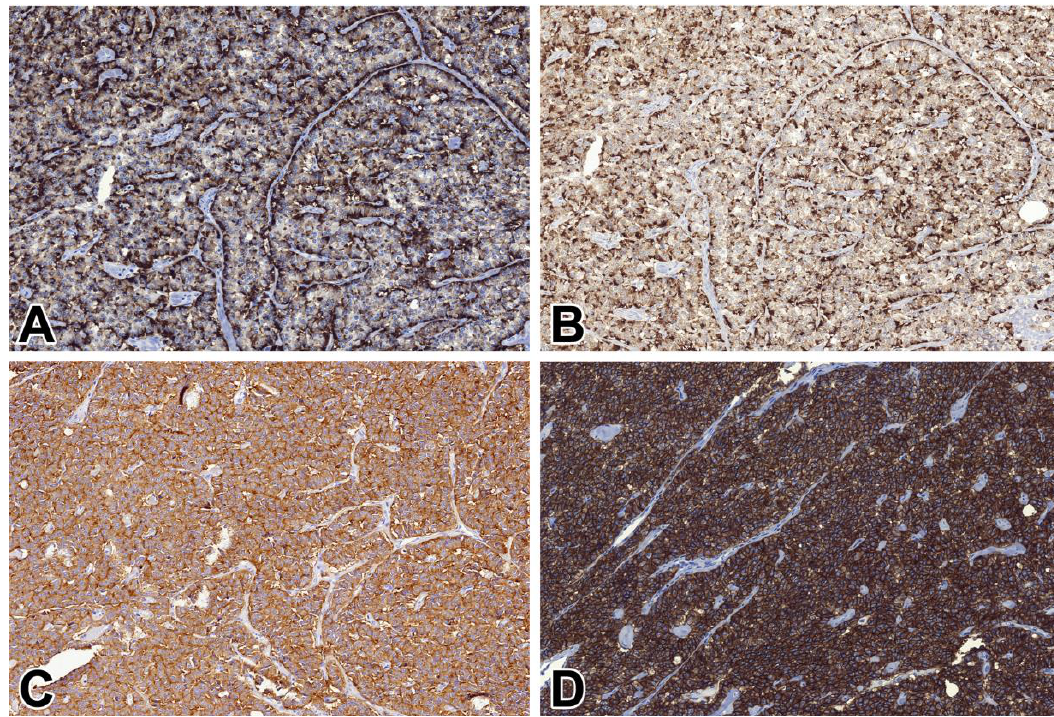
Figure 2. CD56, CHGA, SYP, and STX1 immunoreactivity in a pancreatic non-functioning NE tumor (NET) grade 2. (A) CD56, 20x; (B) CHGA, 20x; (C) SYP, 20x; (D) STX1, 20x.